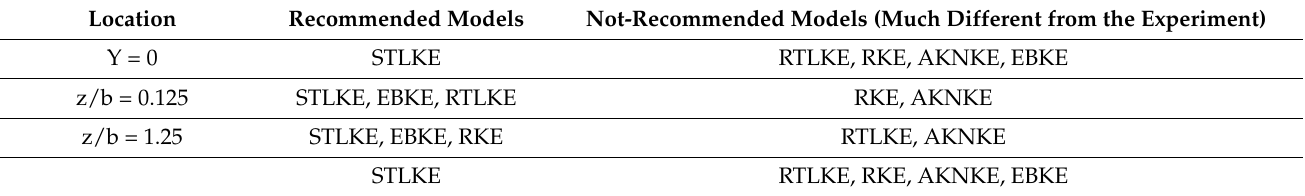
Table 16. Comparison of turbulent kinetic energy in high wind-speed area. Location Recommended